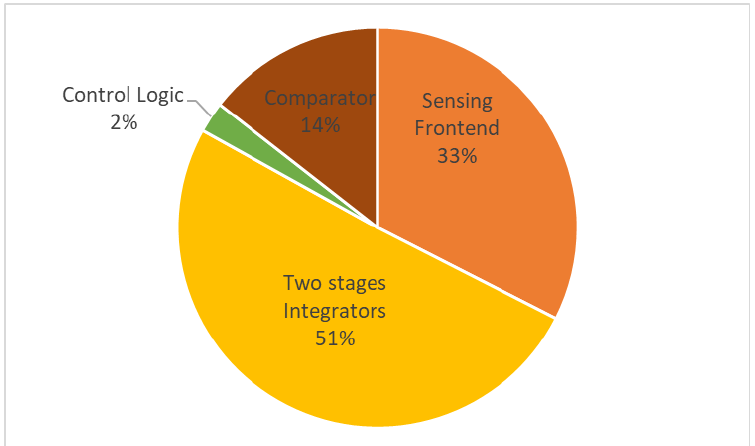
Figure 12. Power consumption